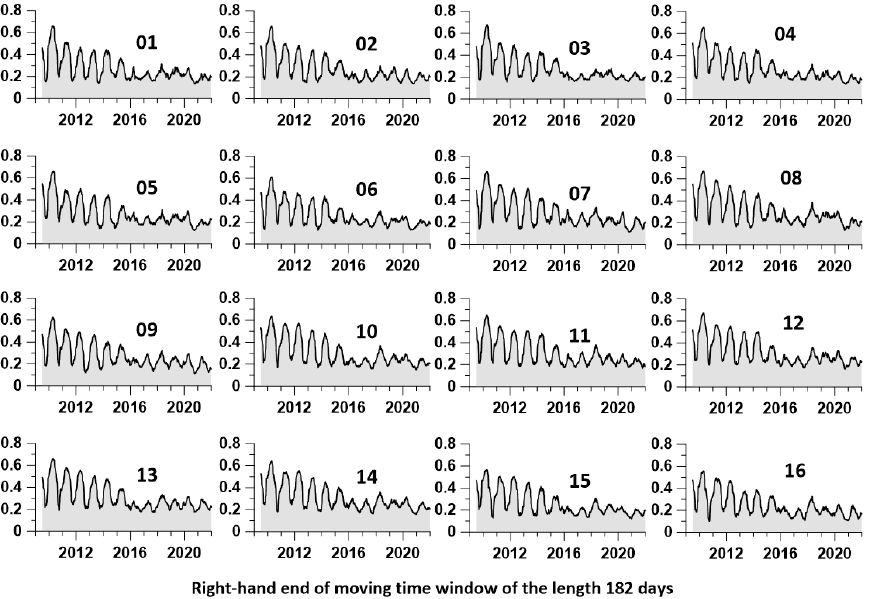
( j ) τ for each reference point with all other